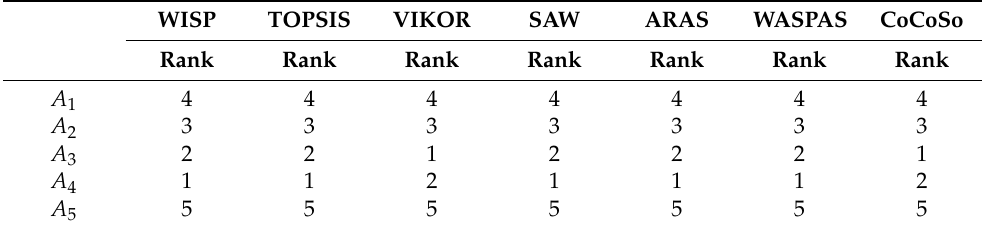
Table 22. Ranking orders obtained using selected MCDM methods.